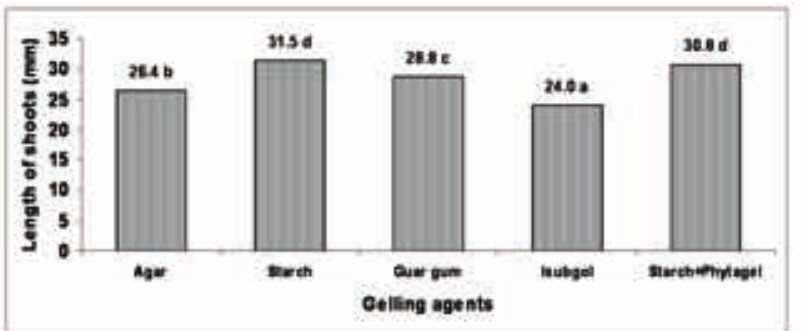
Figure 1. The total numbers of newly developed shoots and numbers of new shoots, longer than 20 mm on media gelled by different gelling agents. Signifi cant differences ( P ≤ 0.05) between the media gelled by different gelling agents are indicated by different